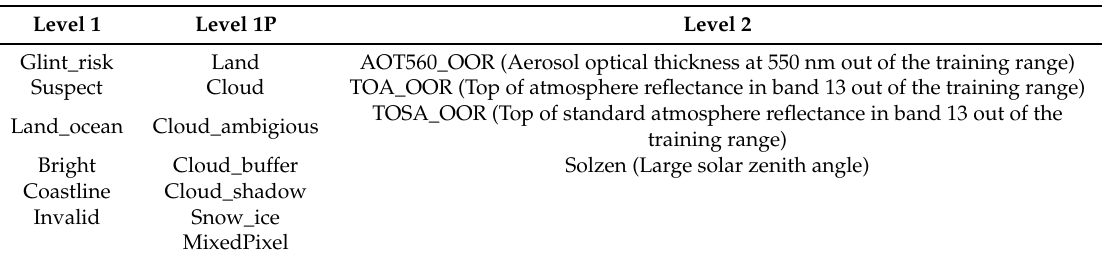
Table 2. Flags of excluded